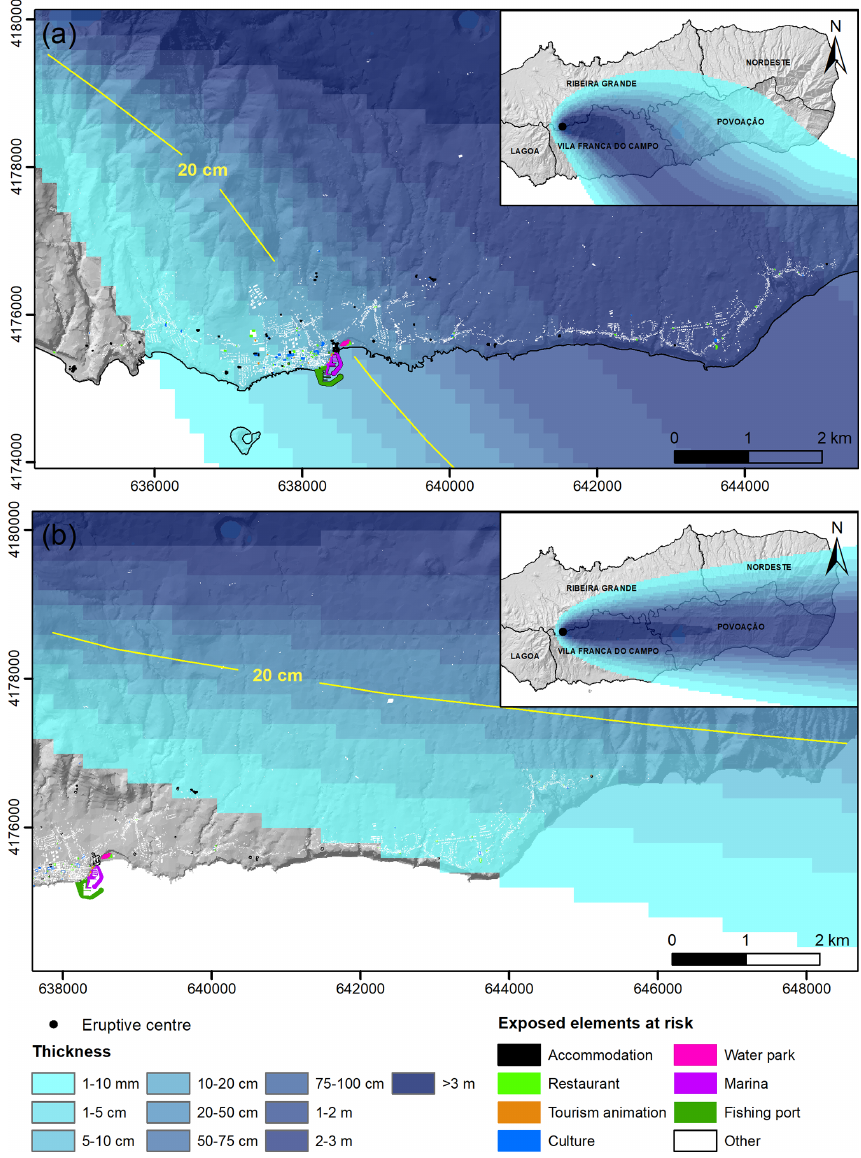
Figure 8. (a) Spatial distribution of the elements at risk in Vila Franca do Campo municipality (colour polygons) affected by tephra fallout resulting from a VEI 5 Plinian eruption of Fogo volcano, considering the dominant winds for the summer period. (b) Spatial distribution of the elements at risk in Vila Franca do Campo municipality affected by tephra fallout resulting from a VEI 5 Plinian eruption of Fogo volcano, considering the dominant winds for the winter period. UTM coordinates, zone 26S, datum WGS